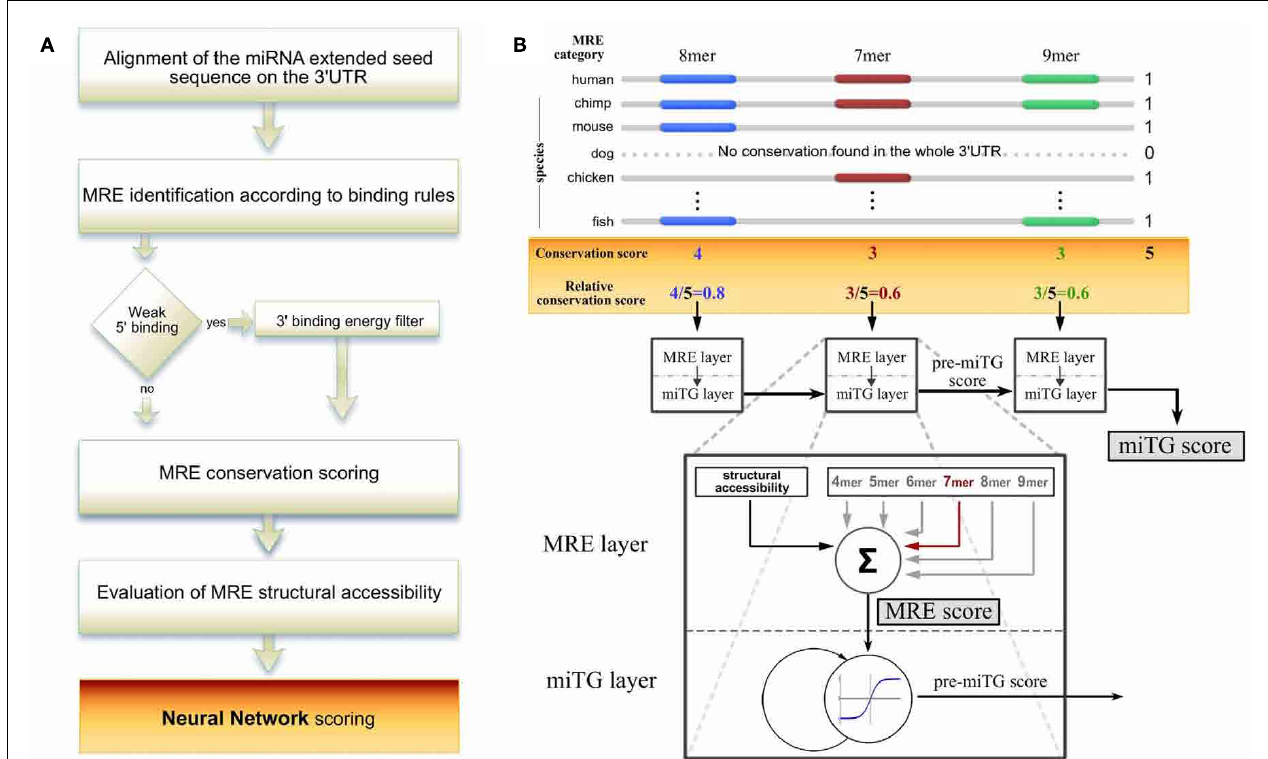
value of the MRE.The following six components correspond to the binding structure classes and have as value the relative conservation score.This vector is the input to a linear neuron that assigns the MRE score by multiplying the features with seven weights.The MRE score is the input to a non-linear neuron in the miTG layer to collect the miTG score. Using a feedback connection, this neuron simulates a saturation effect through a non-linear integration of the MRE scores.The network processes sequentially each MRE as it occurs on the 3 (cid:2) UTR. At each MRE the activity collected as the pre-miTG score from the previous MREs is multiplied with the weight on the feedback connection, added to the current MRE score and passed through a non-linear threshold function.The output is the current pre-miTG score at this particular MRE. After processing the last MRE, this activation is assigned as the final miTG score and reflects the degree of downregulation of the coding gene based on the particular